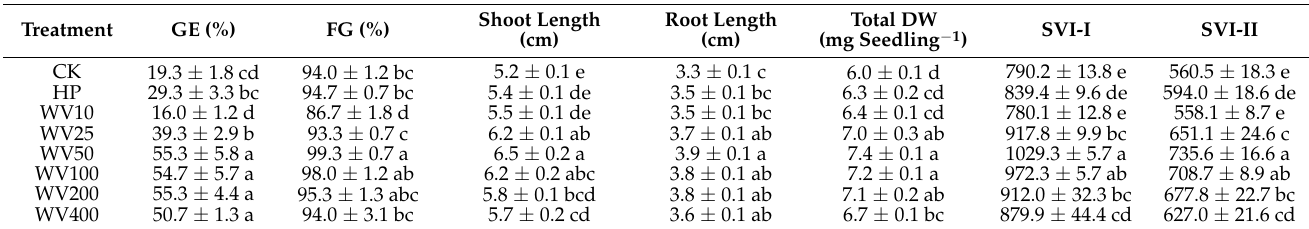
Table 1. Effect of different concentrations of WV on WDR seed germination and seedling growth under growth chamber experiment.